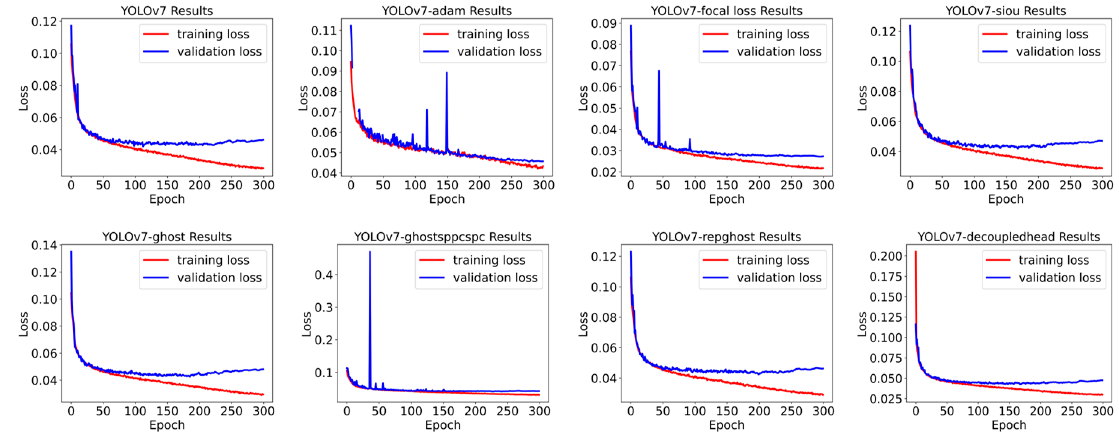
Figure 7. The training process of the different methods introduced into